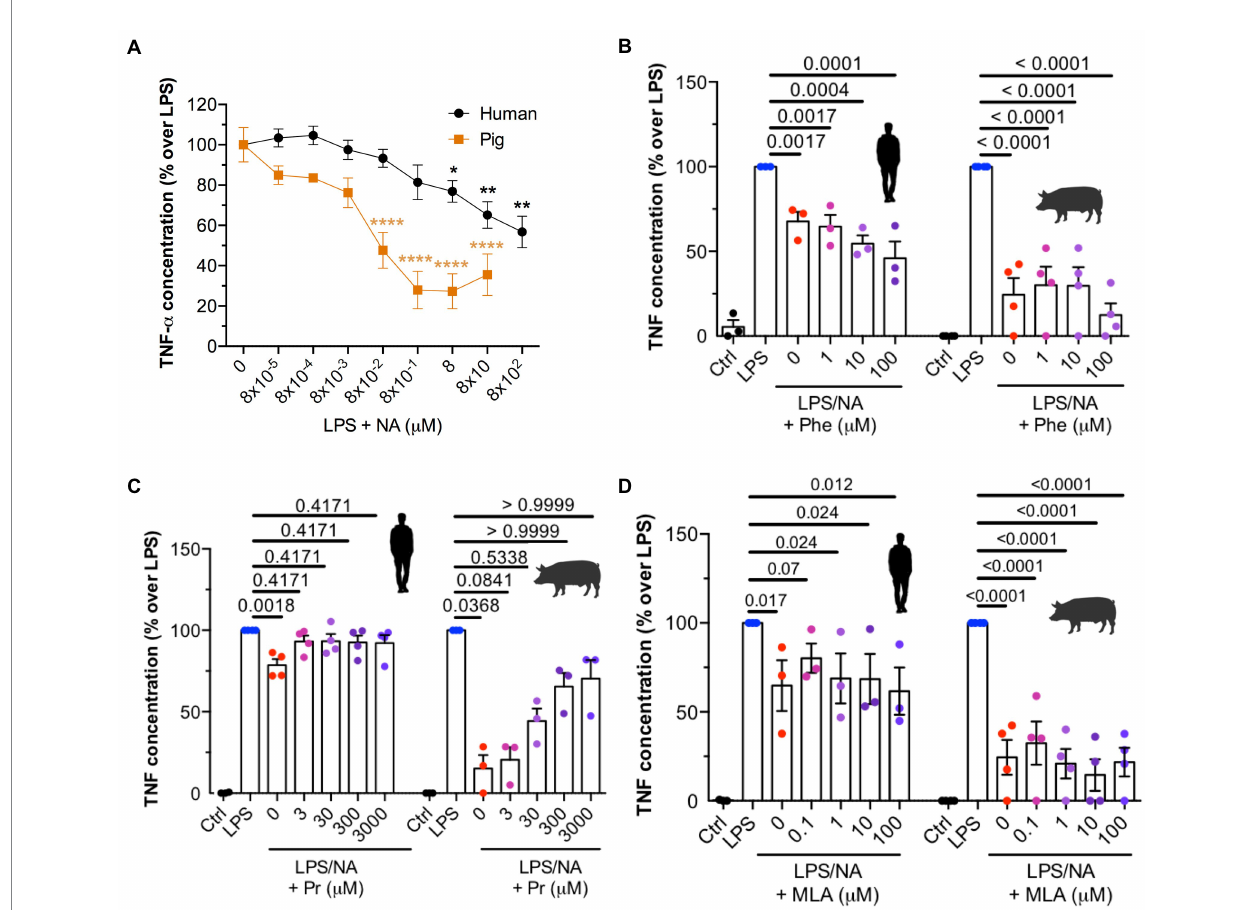
FIGURE 4 NA promotes TNF suppression via β 2 -AR and is independent of α 7-AChR in humans and pigs. (A) Dose dependent change of LPS-induced TNF caused by treatment of human (in black) and pig (in grey) splenocytes with different concentrations of NA (8 × 10 − 5 – 8 × 10 2 μ M). Data are expressed as % over LPS control ( n ≥ 5). (B–D) Quantification of TNF in human and pig splenocytes in medium only (Ctrl), LPS (100 ng/ml), LPS (100 ng/ml) + NA (8 μ M) and LPS (100 ng/ml) + NA (8 μ M) in the presence of various concentrations of α -AR (Phentolamine, Phe), β -AR (Propranolol, Pr) or α 7-AChR (methyllycaconitine, MLA) receptor antagonists. Data are expressed as % over LPS control ( n ≥ 3). All data are expressed as mean ± SEM. For statistical analysis a Kruskal–Wallis followed by Dunn’s post-hoc test were